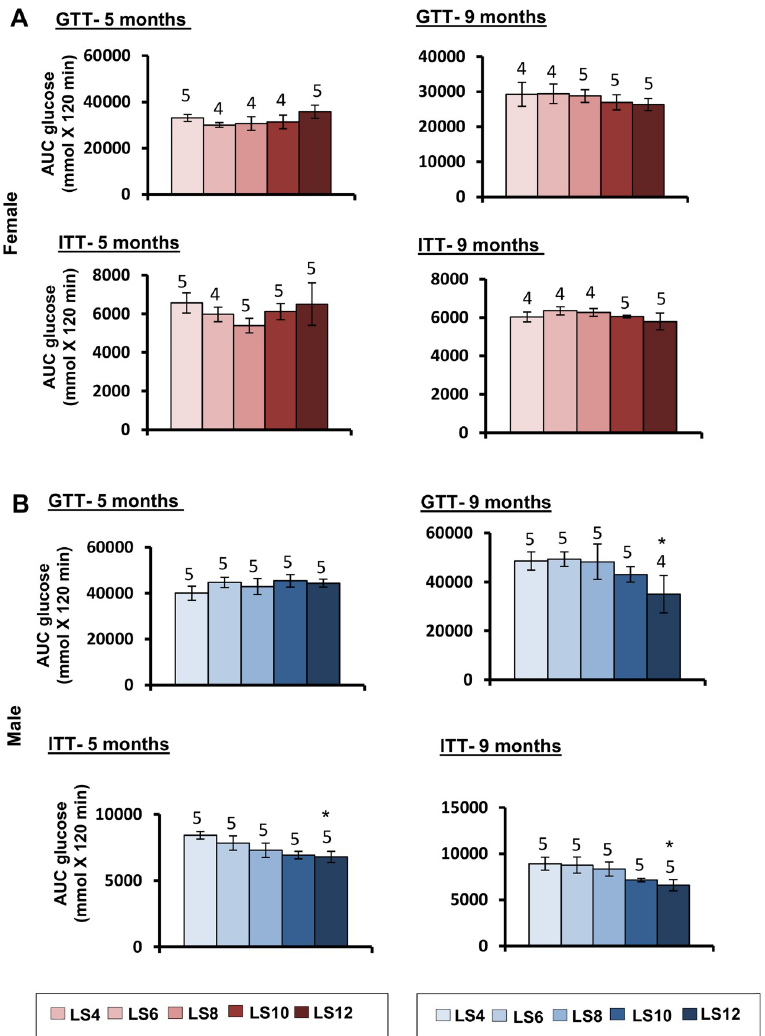
Fig 5. Effect of litter expansion on glucose homeostasis. Glucose tolerance (GTT) and insulin tolerance (ITT) were measured in female (A) and male (B) mice as described in the methods. The data are expressed as the area under the curve (AUC) for mice at 5 and 9 months of age. Data represented are the mean ± SEM from 4–5 mice per group. All groups were compared to control LS6 and were statistically analyzed by one-way ANOVA with Tukey’s and FDR with Benjamini & Hochberg multiple correction test ( � p <